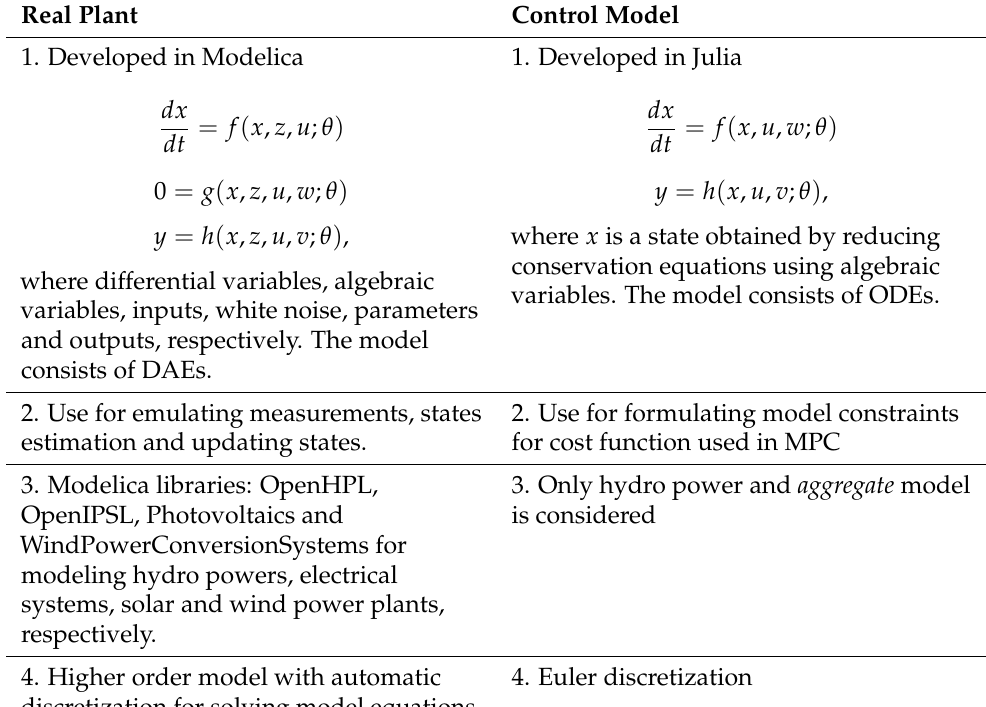
Table 3. Models used for real plant and